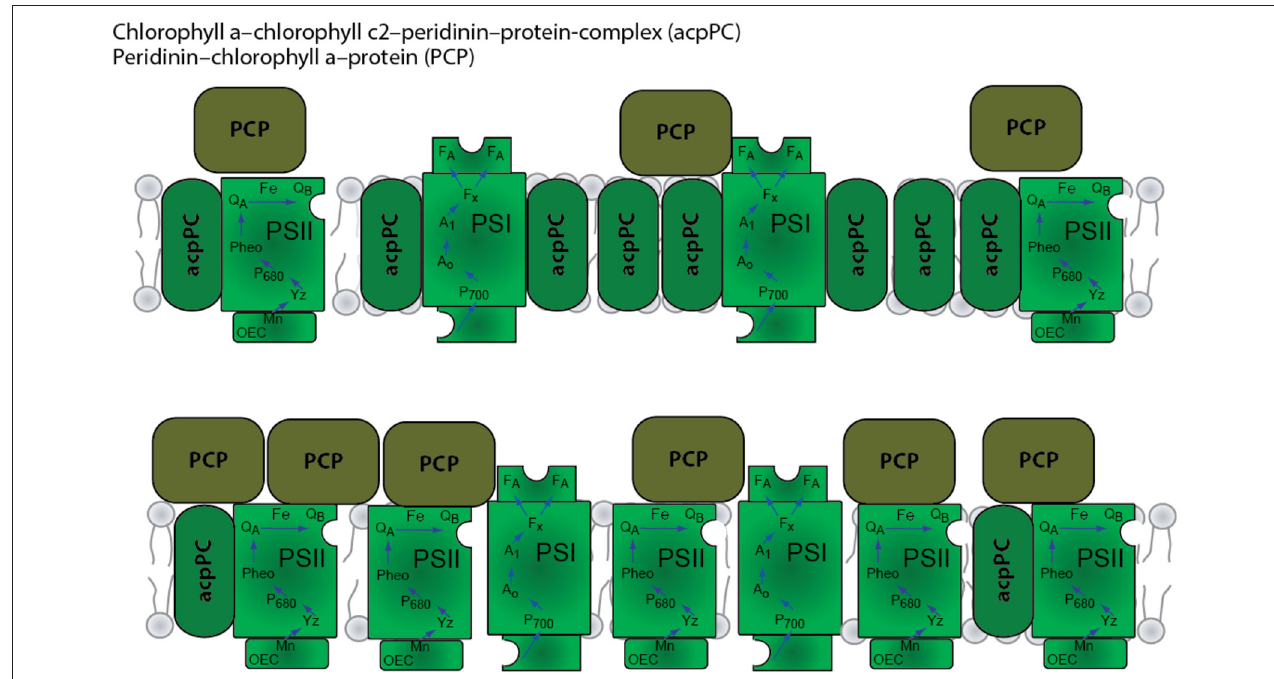
FIGURE 6 | Schematic model of the organization of the photosynthetic apparatus in shallow (top) and mesophotic/deep (bottom)